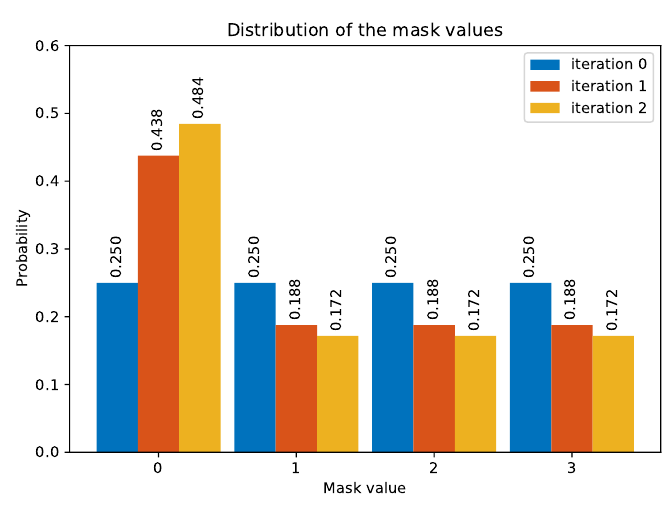
Figure 4: Distribution of mask value ( r + c ) per iteration for k